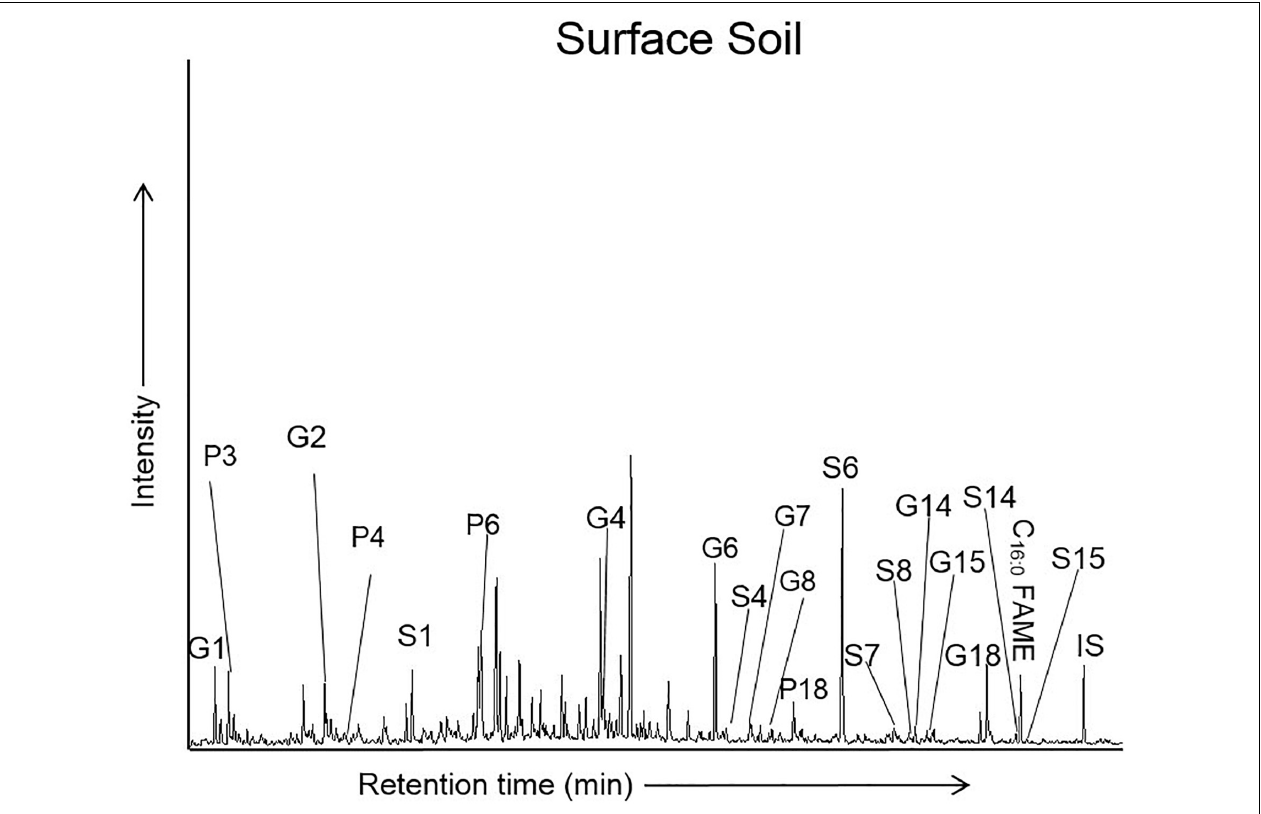
FIGURE 4 | Partial chromatogram for the total ion current (TIC) of thermochemolysis products from a sample of savannah wood surface soil (methylated lignin and tannin phenols). IS, internal standard. Compound key in Table 2 . Full figures for each lignin parameter calculated ( (cid:51) , C/G, S/G, [Ad/Al] G and [Ad/Al] S ) are given in Supplementary Table 1 . Values are given for both 13 C-labeled TMAH corrected parameters (indicated with a *) and uncorrected values (without a *).